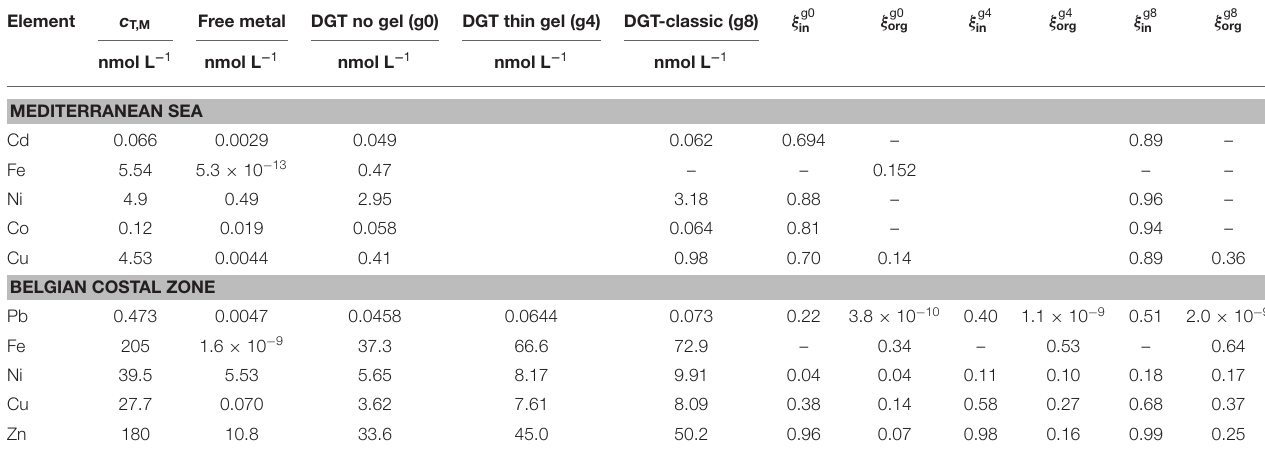
TABLE 3 | Lability degrees ( ξ ) of metal complexes obtained in the Mediterranean Sea and in the Belgian coastal Zone (BCZ) (Gao et al., 2019). Element c T,M